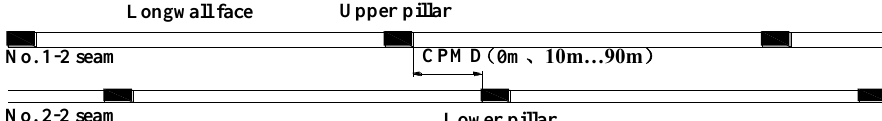
Figure 6. CPMD of coal seams. 3.2. Stress Field Evolution of SBCSM-S Mining (1) Stress transfer characteristics of No. 1–2 seam mining After mining of No. 1–2 seam, according to the data monitored in monitoring zones No. 1–4, stress distribution characteristics of No. 1–2 and No. 2–2 seams are shown in Figure 7. The results show that the maximum vertical stress, concentrated at the center of upper pillar, is 20.56 MPa, and it is about 5.7 times the virgin in-situ stress, whereas, it gradually decreases to two sides. In due to complete subsidence of the overlying strata, the vertical stress in the middle area (45 m) of longwall face is also higher than the other position of goaf.